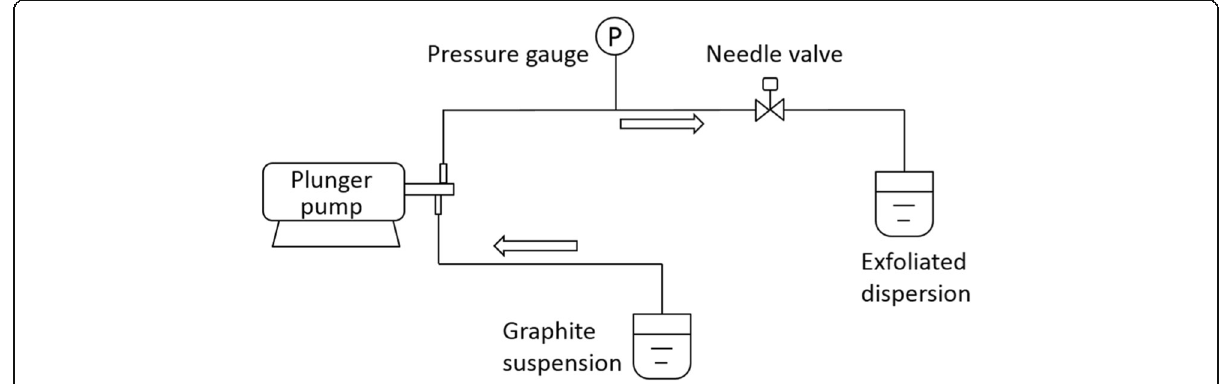
Fig. 2 Schematic diagram of the hydrodynamic-assisted exfoliation process